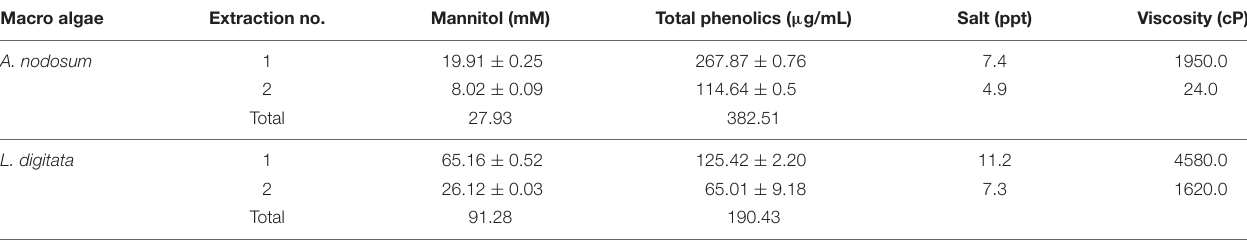
TABLE 2 | Preparative scale extraction of mannitol from brown macro algae. Macro algae